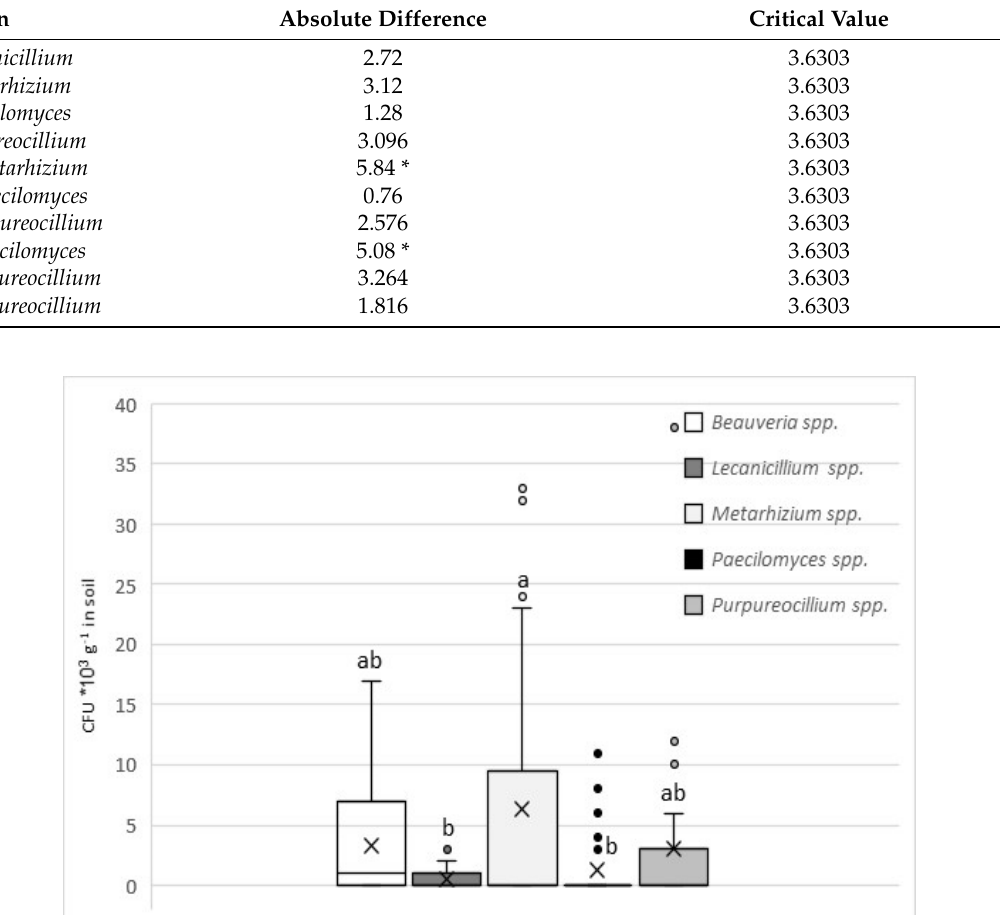
Table 4. Comparison of the mean number of fungal colony-forming units (CFU g − 1 ) in soil in the localities, using the Tukey’s method to compare CFU estimates (* indicates significance at p < 0.05).